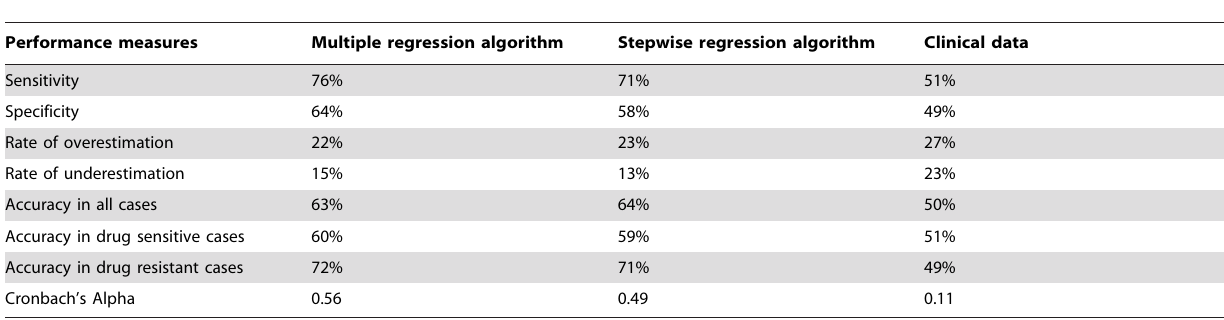
Table 3. Comparision of performance of new algorithms with clinical data.